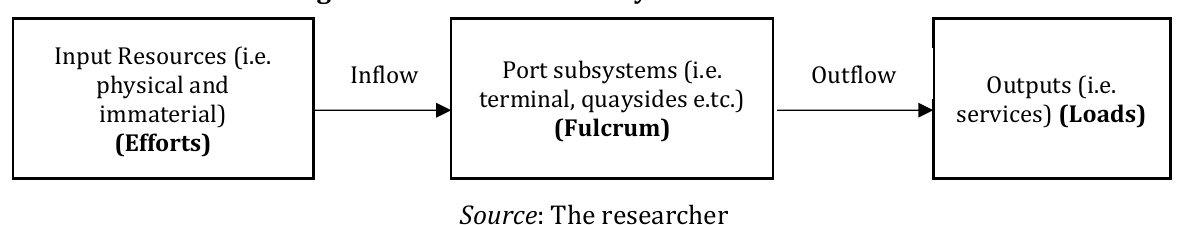
Figure 1: Port Production System or Mechanism